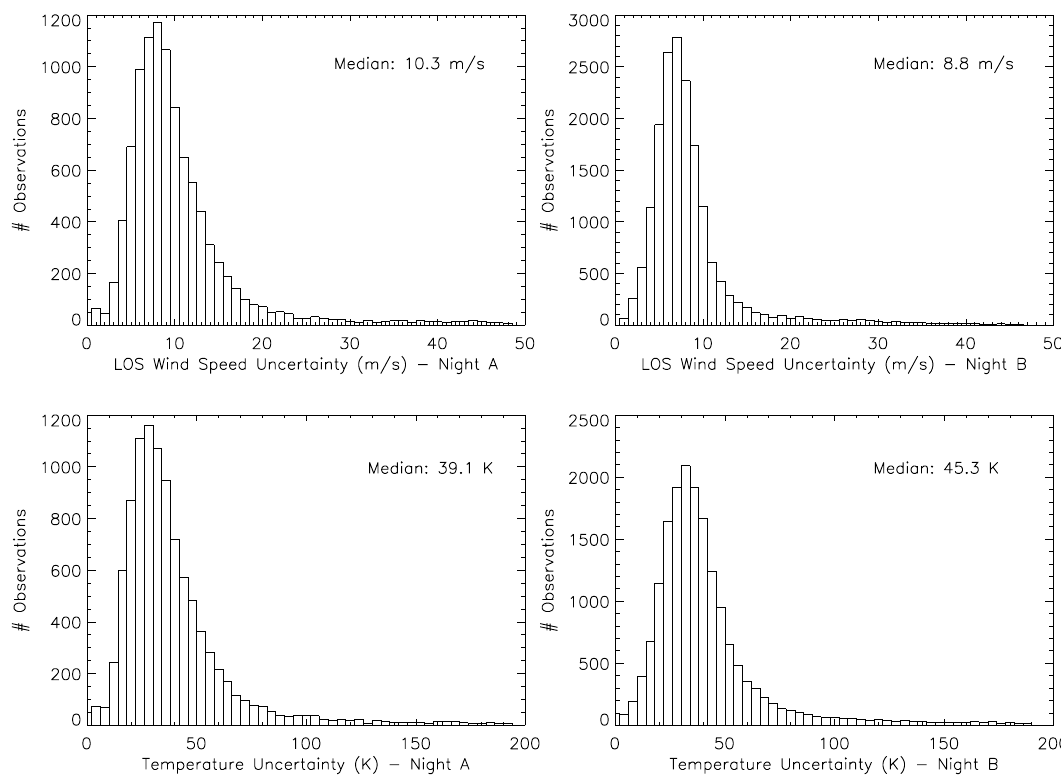
Fig. 5. Histograms of line-of-sight wind and temperature uncertainties for nights A and B, across all